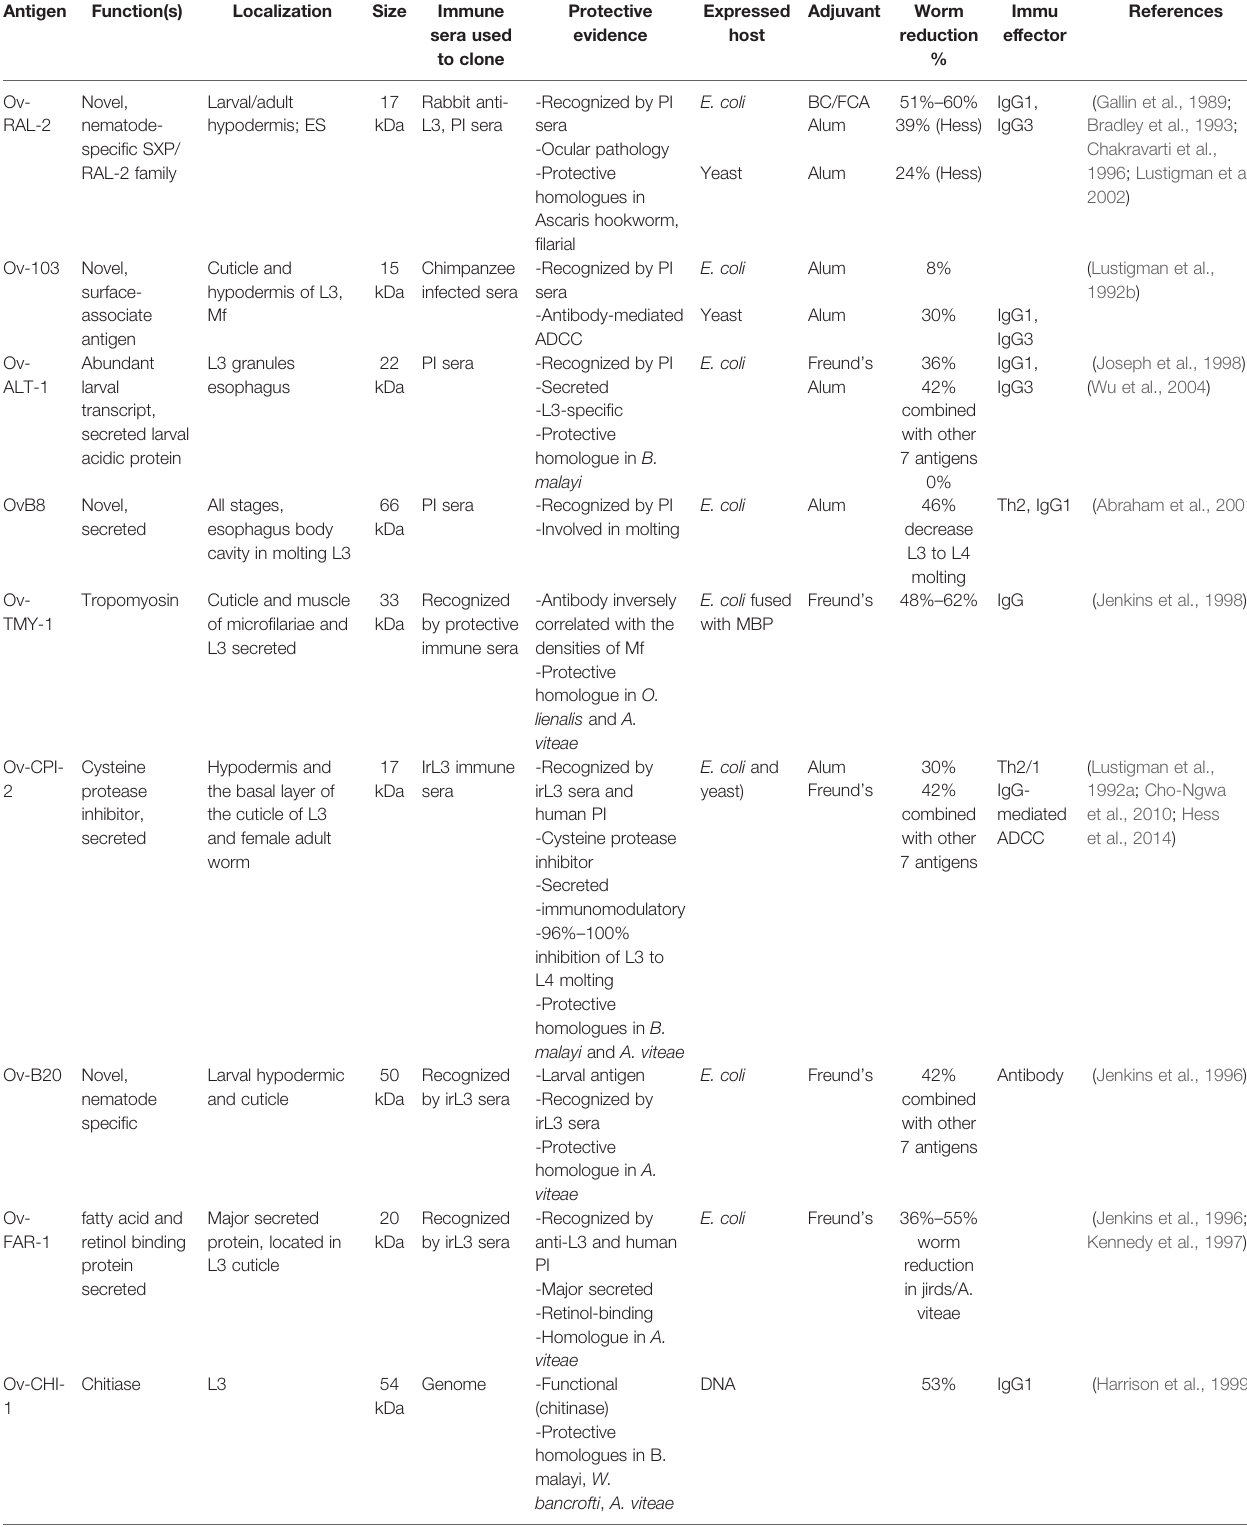
TABLE 1 | The characteristics of major vaccine candidates for